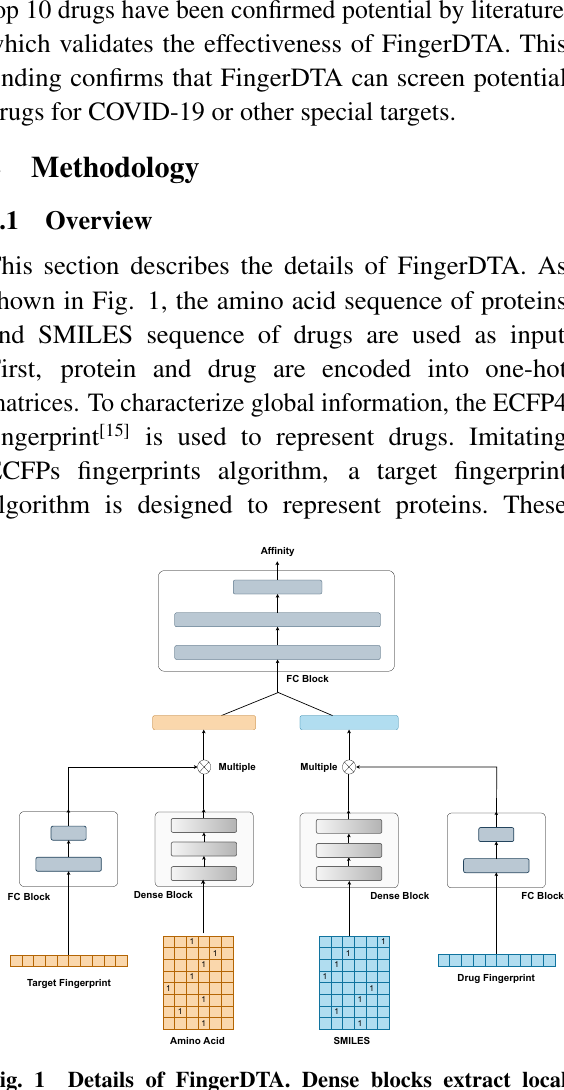
Fig. 1 Details of FingerDTA. Dense blocks extract local features from one-hot matrices, and FC layers compress fingerprints into global features. Then, FingerDTA utilizes these features to predict drug-target affinity